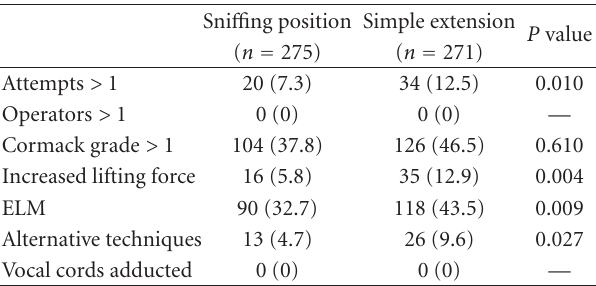
Table 5: Variables of the intubation di ffi culty scale.